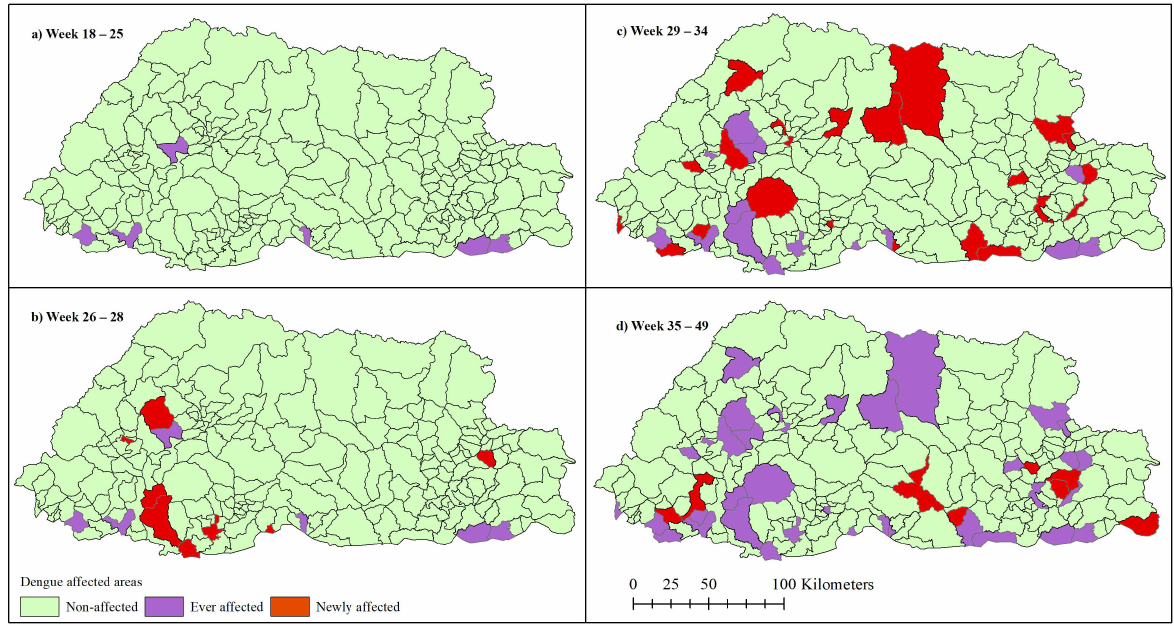
Figure 3. The changing spatiotemporal pattern of 2019 dengue epidemic in Bhutan at the subdistrict level. The epidemic initially started with six subdistricts as shown in the first panel in the top-left map ( a ). These subdistricts have also reported dengue in the past. The epidemic spread to 8, 22, and 8 new subdistricts in weeks 26–28 ( b ), 29–34 ( c ), and 35–49 ( d ), respectively, that summed to 44 subdistricts at the